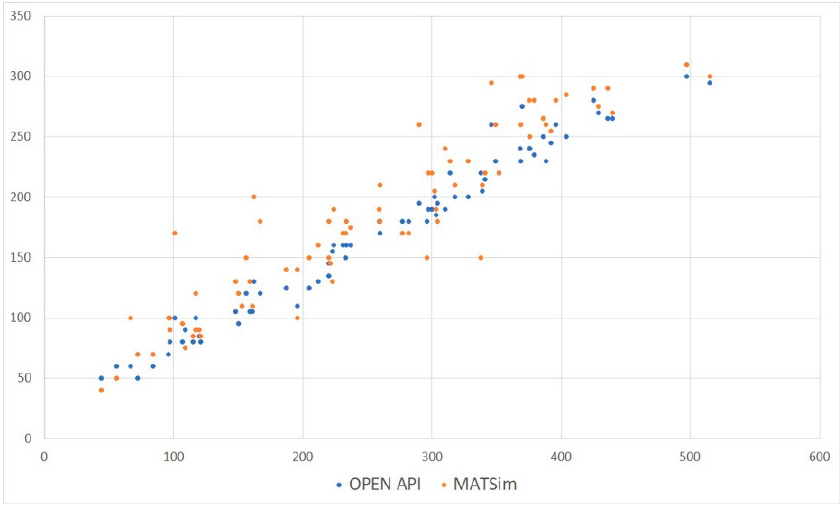
Figure 2. Scatter gram for travel time (minutes) for selected origin–destination pairs.